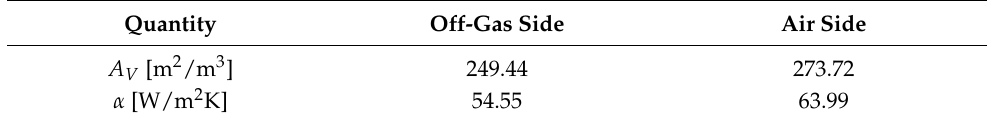
Table 5. Parameters for the heat transfer inside the